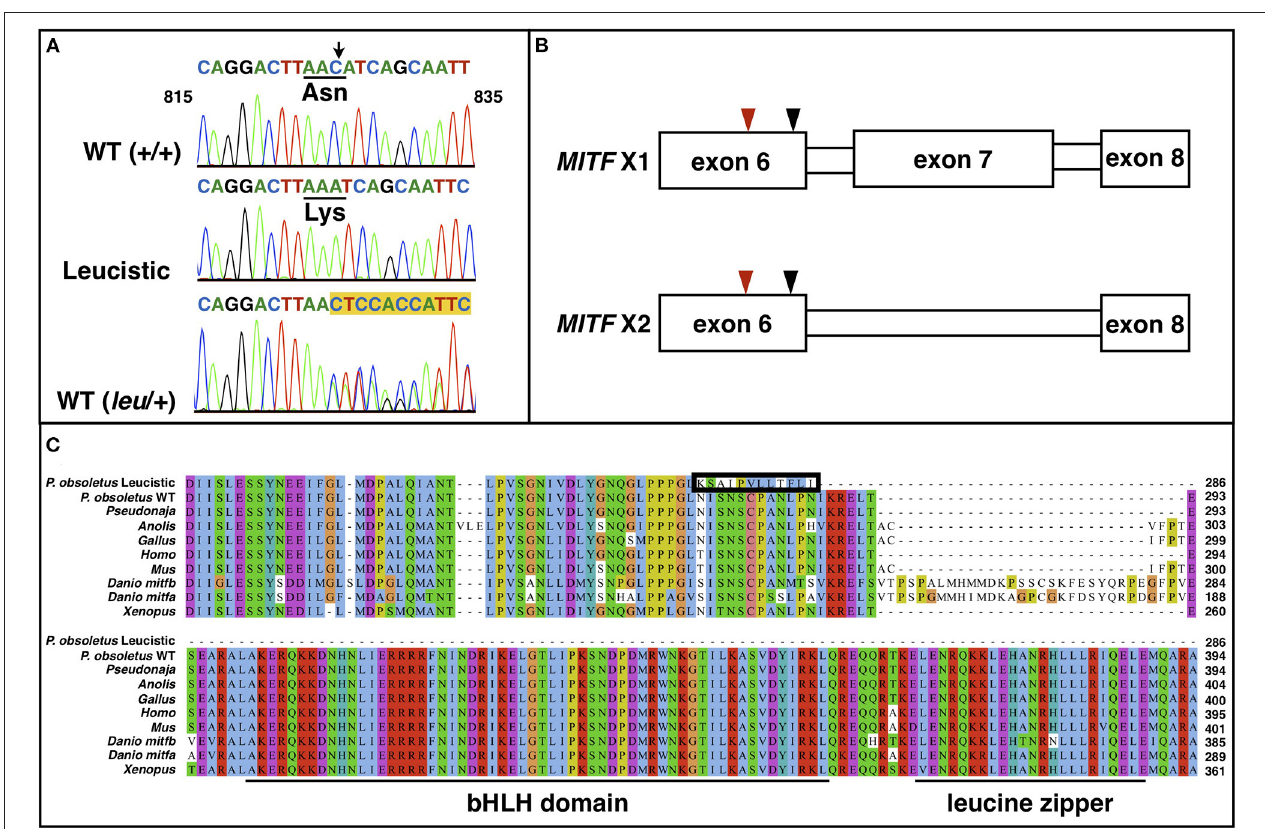
FIGURE 4 | (A) Chromatogram sequences of MITF between positions 815 and 835 of a WT ( + / + ), a leucistic and an heterozygous WT snake. The black arrow points to the deleted cytosine. The amino acid change is shown. Highlighted in yellow are the double peaks in the heterozygous individual. (B) Representation of the two MITF isoforms, which only differ by the presence/absence of exon 7. The red arrowhead points to the location of the cytosine deletion, while the black one indicates the location of the premature stop codon. (C) Multiple sequence alignment of MITF proteins from different vertebrate lineages along with the wild type (isoform X2 in 4B) and leucistic Pantherophis obsoletus MITF. The 12 amino acids that are modified in the leucistic MITF after the frameshift and before the premature stop codon are included in the black box. The basic helix-loop-helix and the leucine zipper domain are underlined.